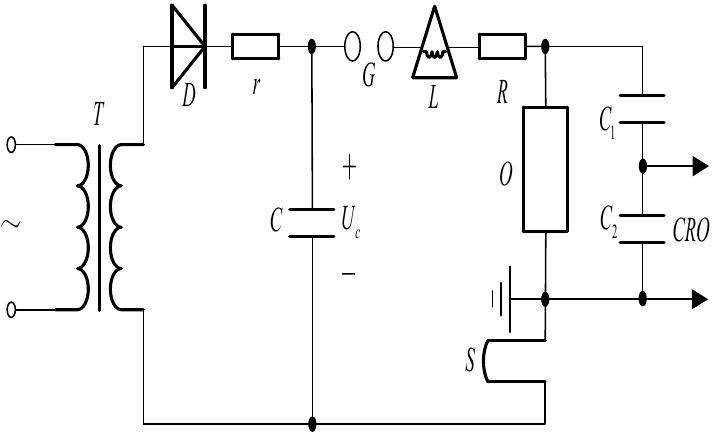
Figure 2. Basic circuit of an inrush current generator.